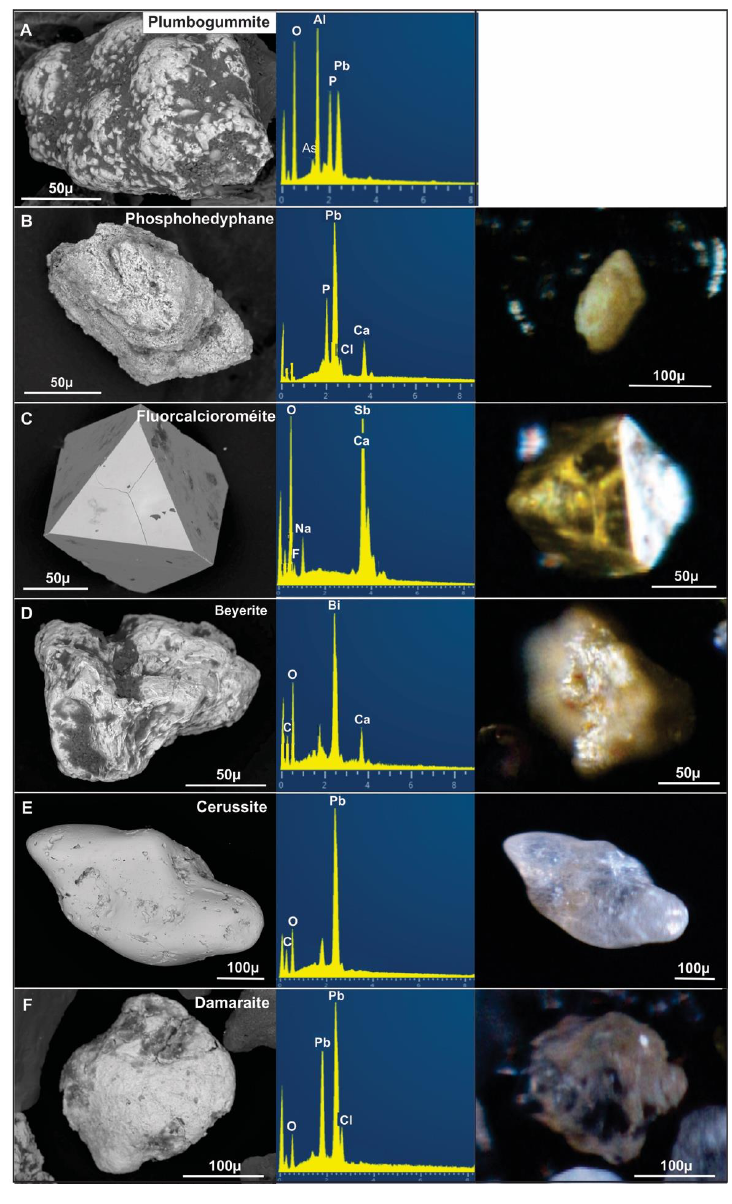
Figure 8. BSE images, EDS spectra, and photograph triplets of carbonates, antimonates, and halides in the heavy mineral concentrate. ( A ) Plumbogummite; ( B ) Phosphohedyphane; ( C ) Fluorcal- cioroméite; ( D ) Beyerite; ( E ) Cerussite; ( F ) Damaraite.